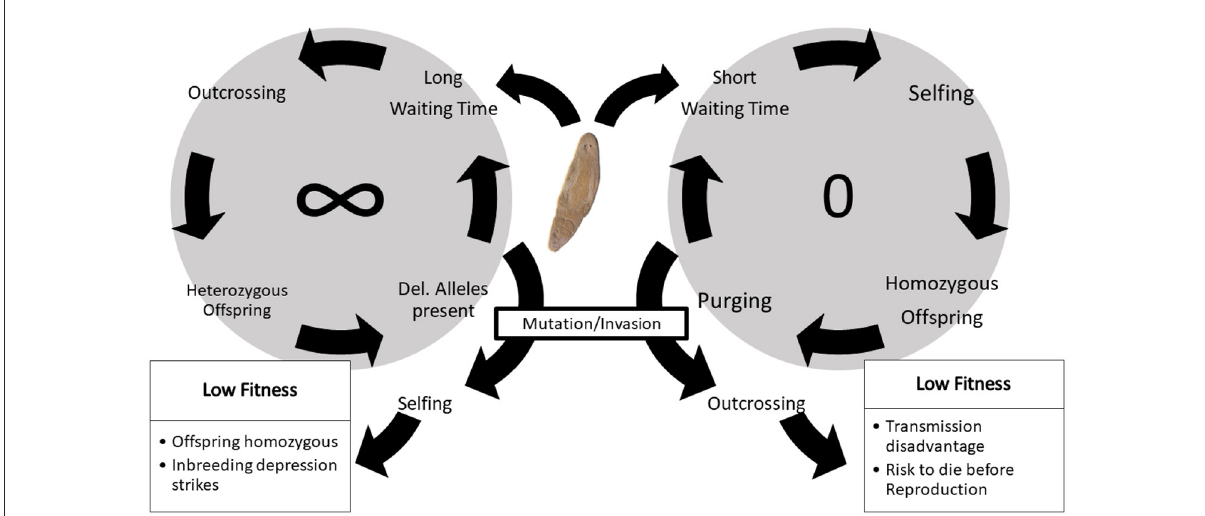
FIGURE8 Positive feedback loops forming alternative stable states, and invasion scenarios. If most individuals have long WTs and reproduce mostly via outcrossing ( left loop), deleterious alleles can drift to higher frequencies, making selfing more costly and leading to even higher WTs. A mutant with a short WT would have a large disadvantage in this system, as its offspring would likely be homozygous for some recessive deleterious mutations, and therefore express ID. Even an invader with a short WT and purged deleterious alleles would potentially have a disadvantage in later generations, because it might meet a resident and produce offspring with intermediate WTs and higher mutational load than the invader parent. At the other extreme, i.e., if most individuals have short WTs and self frequently ( right loop), recessive deleterious mutations are purged out of the population and selfing no longer has a cost. A mutant with a long WT will then not have any advantage and only has a higher risk of death before reproduction. Moreover, it will have a transmission disadvantage because the long-waiting mutant shares the saved-up eggs with its partner, which will have already released most of its eggs in previous selfing events. The photo in the middle shows an individual of the flatworm Macrostomum hystrix . Photo by Schärer, available under: https://commons.wikimedia.org/wiki/File:Macrostomum_hystrix.jpg. licenced under https://creativecommons.org/licenses/by-sa/2.0/deed.en (CC BY-SA